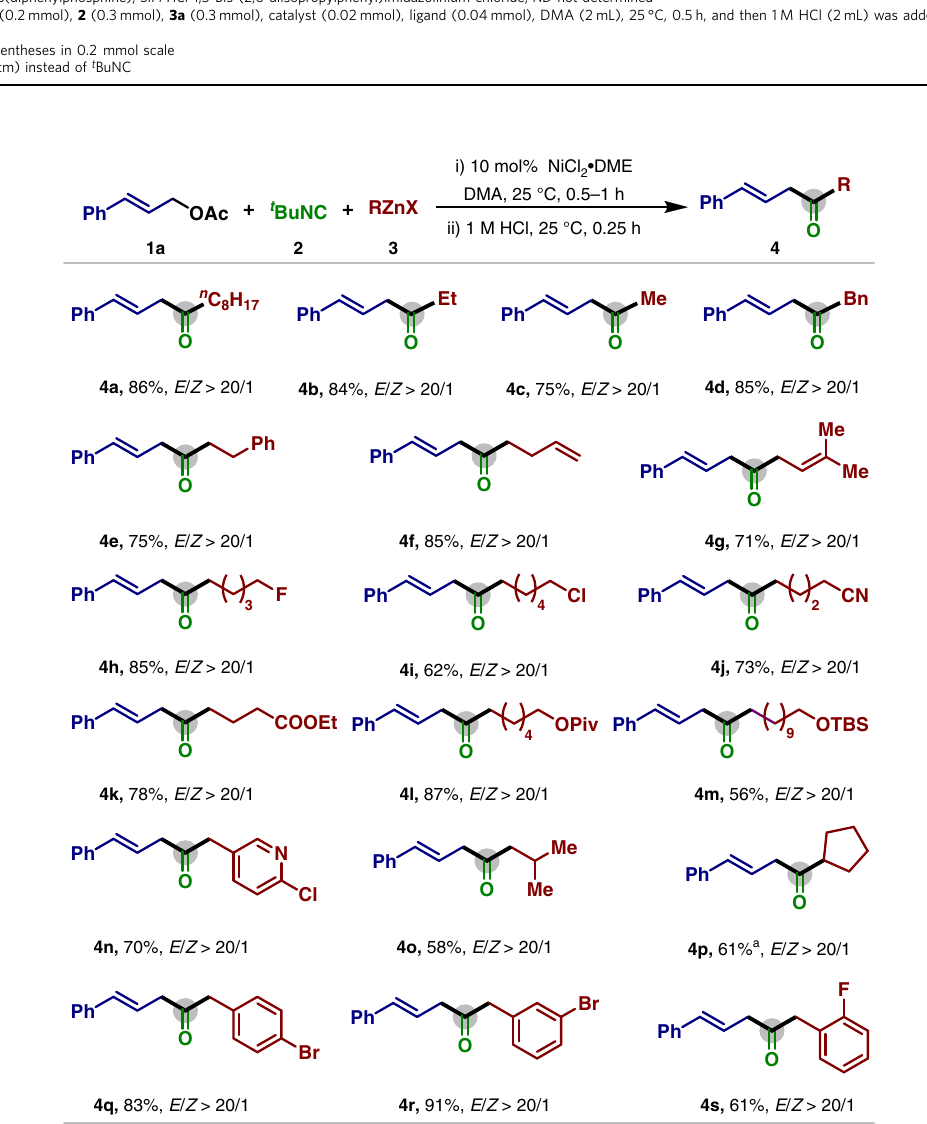
Fig. 2 Scope of alkyl zinc reagent for nickel-catalyzed allylic carbonylative Negishi reaction. Reaction conditions: 1a (0.2 mmol), 2 (0.3 mmol),